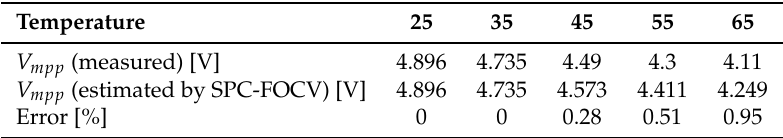
Table 8. Comparison between directly measured and SPC-FOCV estimated V mpp voltage for different temperature